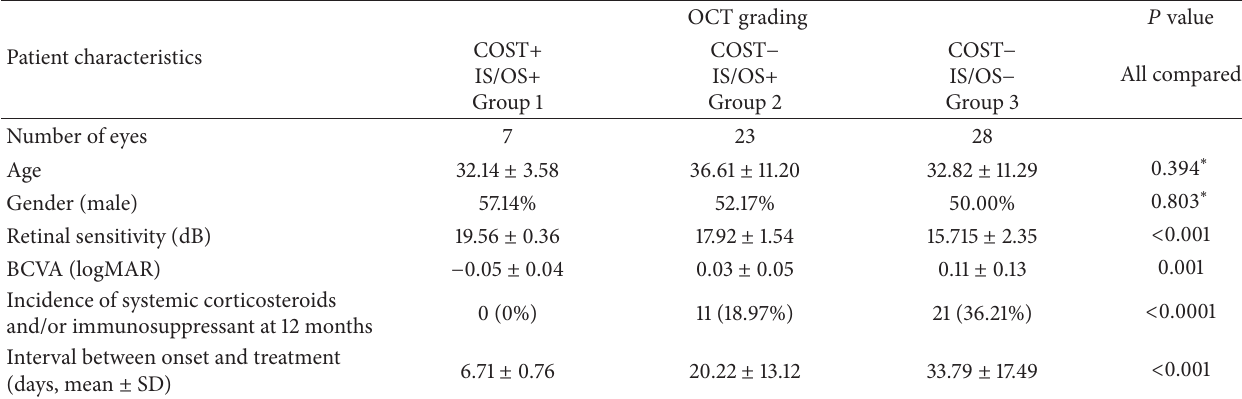
Table 3: Visual function and other clinical findings in 29 late-stage VKH patients with different IS/OS and COST findings.